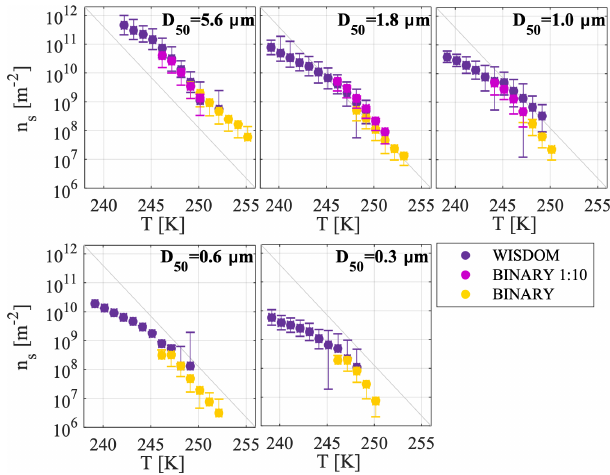
Figure 8. Complementary measurements of WISDOM and BI- NARY for CSDS. Analysis in BINARY was performed to increase the detection sensitivity of ice-active site densities. Two suspensions with different dilution factors were analyzed by BINARY and are compared here to the WISDOM data for the different size